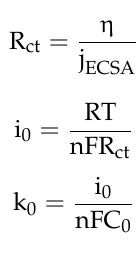
Figure 7. ECSA-adjusted linear sweep voltammograms on carbon black (CB)- and GnP-modified carbon paper (29AA) and carbon cloth (HCB1071) electrodes. Potential scan rate, 1 mV s − 1 ; 3 M HBr/1 M Br 2 electrolyte; temperature, 298 K.